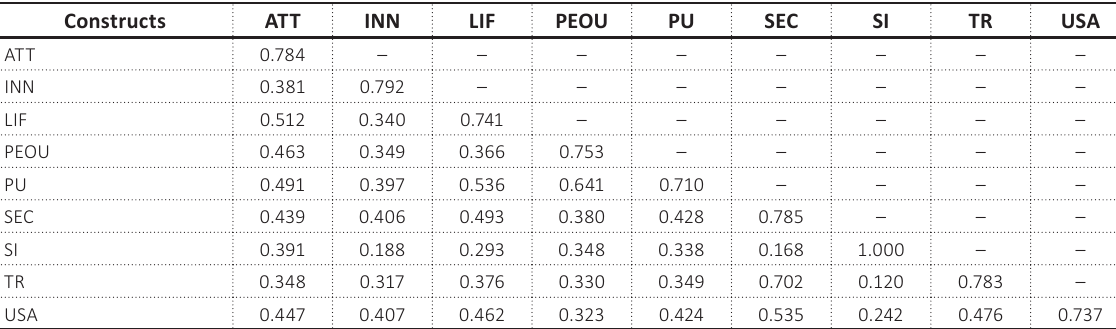
Table 3. Fornell – Larcker criterion for discriminant validity